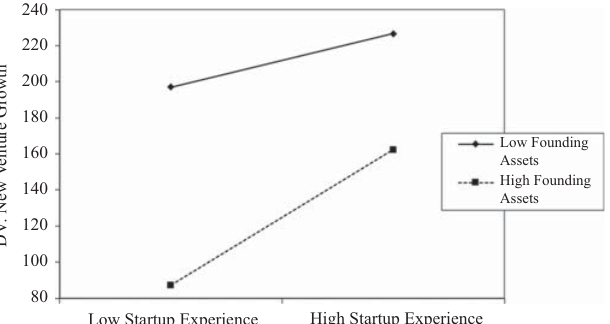
Figure 1. Interaction between education and founding assets